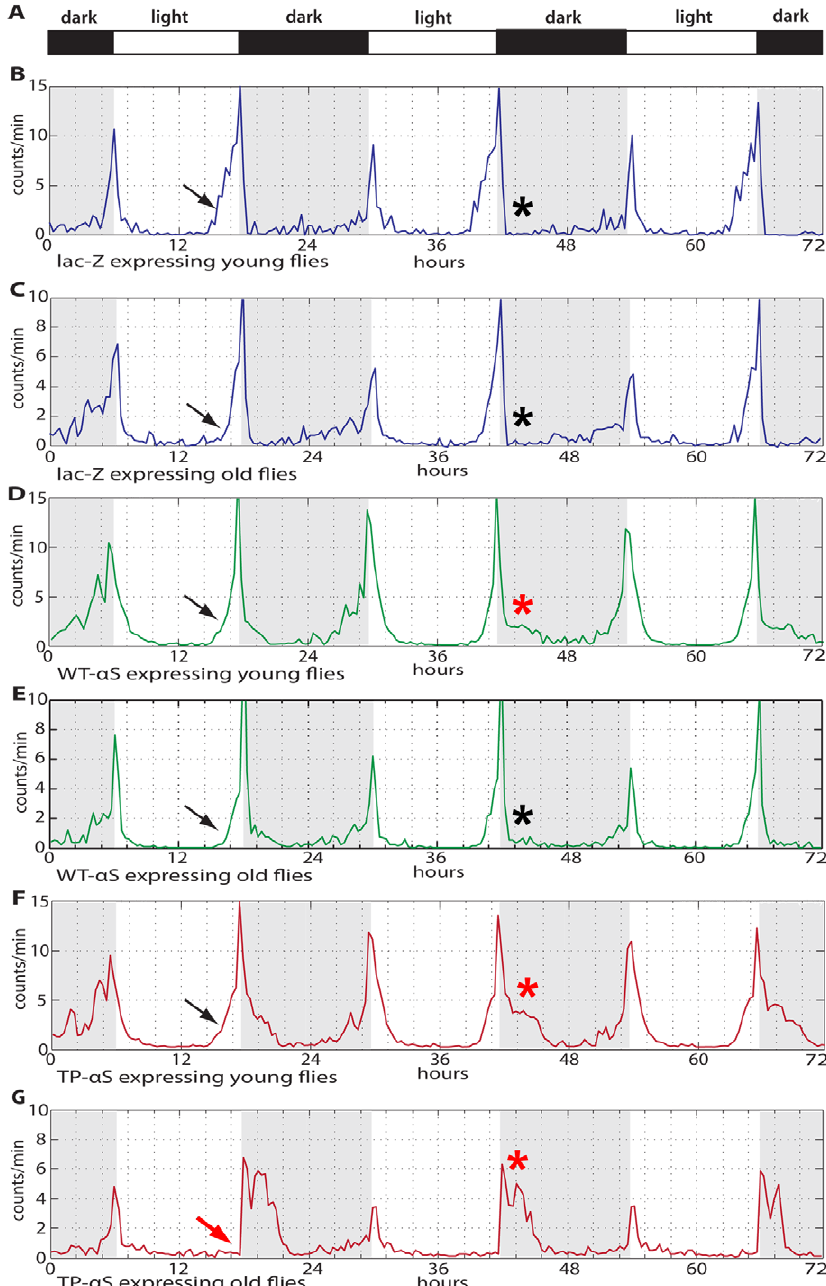
Figure 2. Locomotor activity and anticipation of the dark-light transition of flies expressing lacZ , wild type a S and the oligomer- forming TP- a S mutant. ( A ) Dark-light (D:L=12 hrs:12 hrs) transition bar. ( B–G ) Locomotor activity profile of young flies (3 days after hatching; B , D , F ) and old flies (30 days after hatching; C , E , G ); expressing lacZ (blue line; B , C ), WT- a S (green line; D , E ) and TP- a S (red line; F , G ). Black arrows point to the beginning of locomotor activity prior to the onset of light (anticipatory behavior of the flies). Note that old flies expressing TP- a S fail to anticipate the onset of the light period (red arrow in F ). Red asterisks show the phasing out of the maximum locomotor activities after the light-dark switch. For details see text.